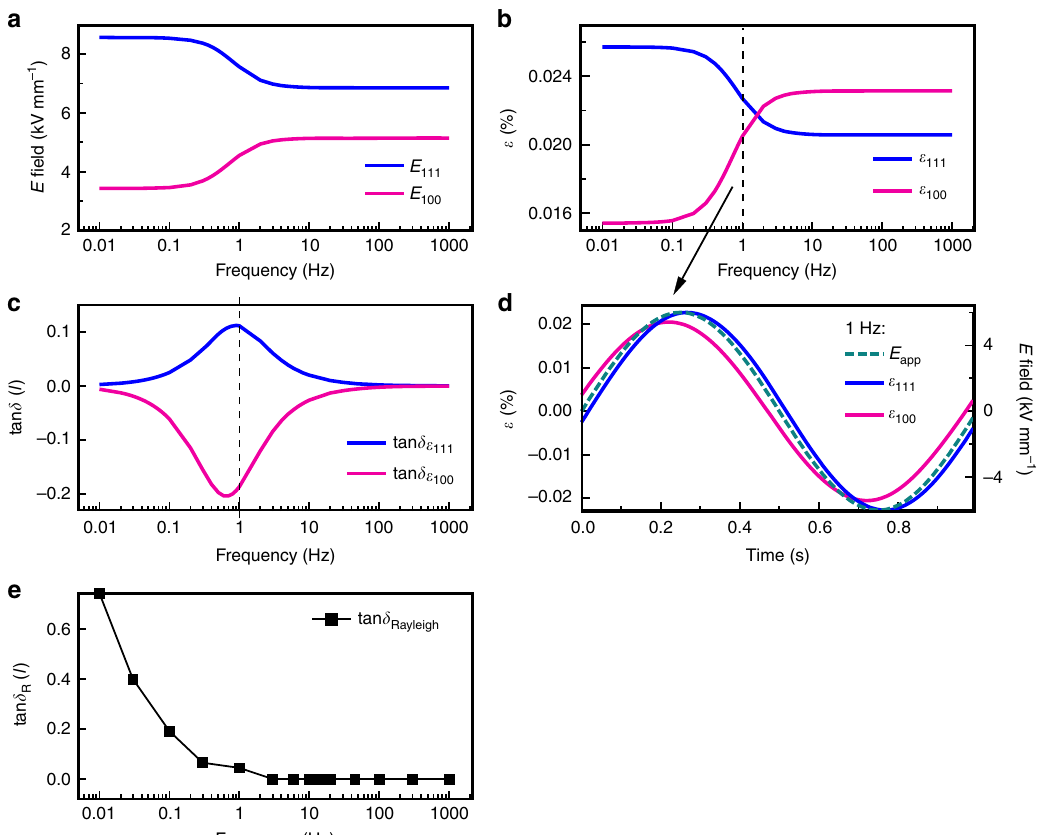
Fig. 5 Maxwell – Wagner analytical model and Rayleigh relationship calculations. a Redistributed effective fi elds, E 100 and E 111 , in the two representative grains due to domain wall conductivity; b frequency dispersion and frequency-dependent decoupling of strain responses, ε 100 and ε 111 , in {100} pc and {111} pc grain families calculated from effective fi eld redistribution using piezoelectric equations; c phase angle, tan δ ε grain family; and d time-dependent electric fi eld and strains in two grains demonstrated for 1 Hz driving frequency. Calculations were made using equations (4) – (7) with relative permittivity κ 100 = 40, κ 111 = 30, relative conductivity σ 100 = 250, σ 111 = 100, piezoelectric coef fi cient d 100 = 45 pm V − 1 , d 111 = 30 pm V − 1 , and volume fractions of each grain v 100 = v 111 = 0.5. e Rayleigh phase angle due to the signi fi cant non-linearity at frequencies below ~1 Hz calculated from the experimental irreversible parameter, α (see Supplementary Figure